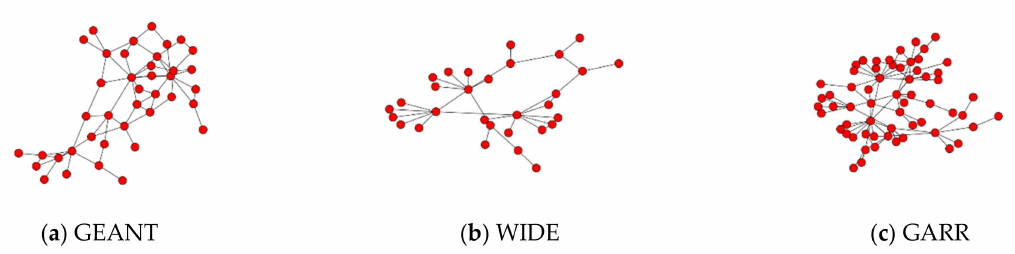
Figure 3. Simulation topologies.